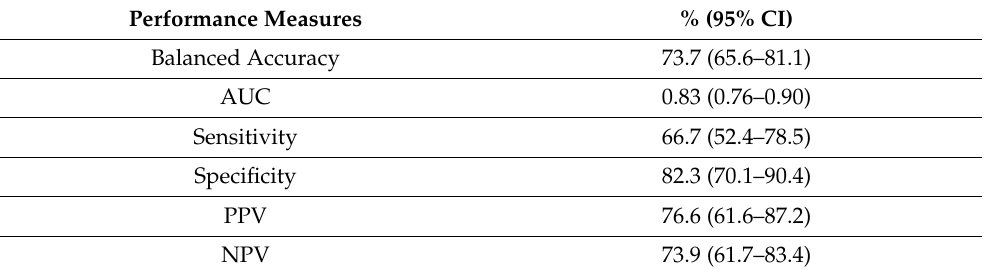
Table 3. Final SVM model performance